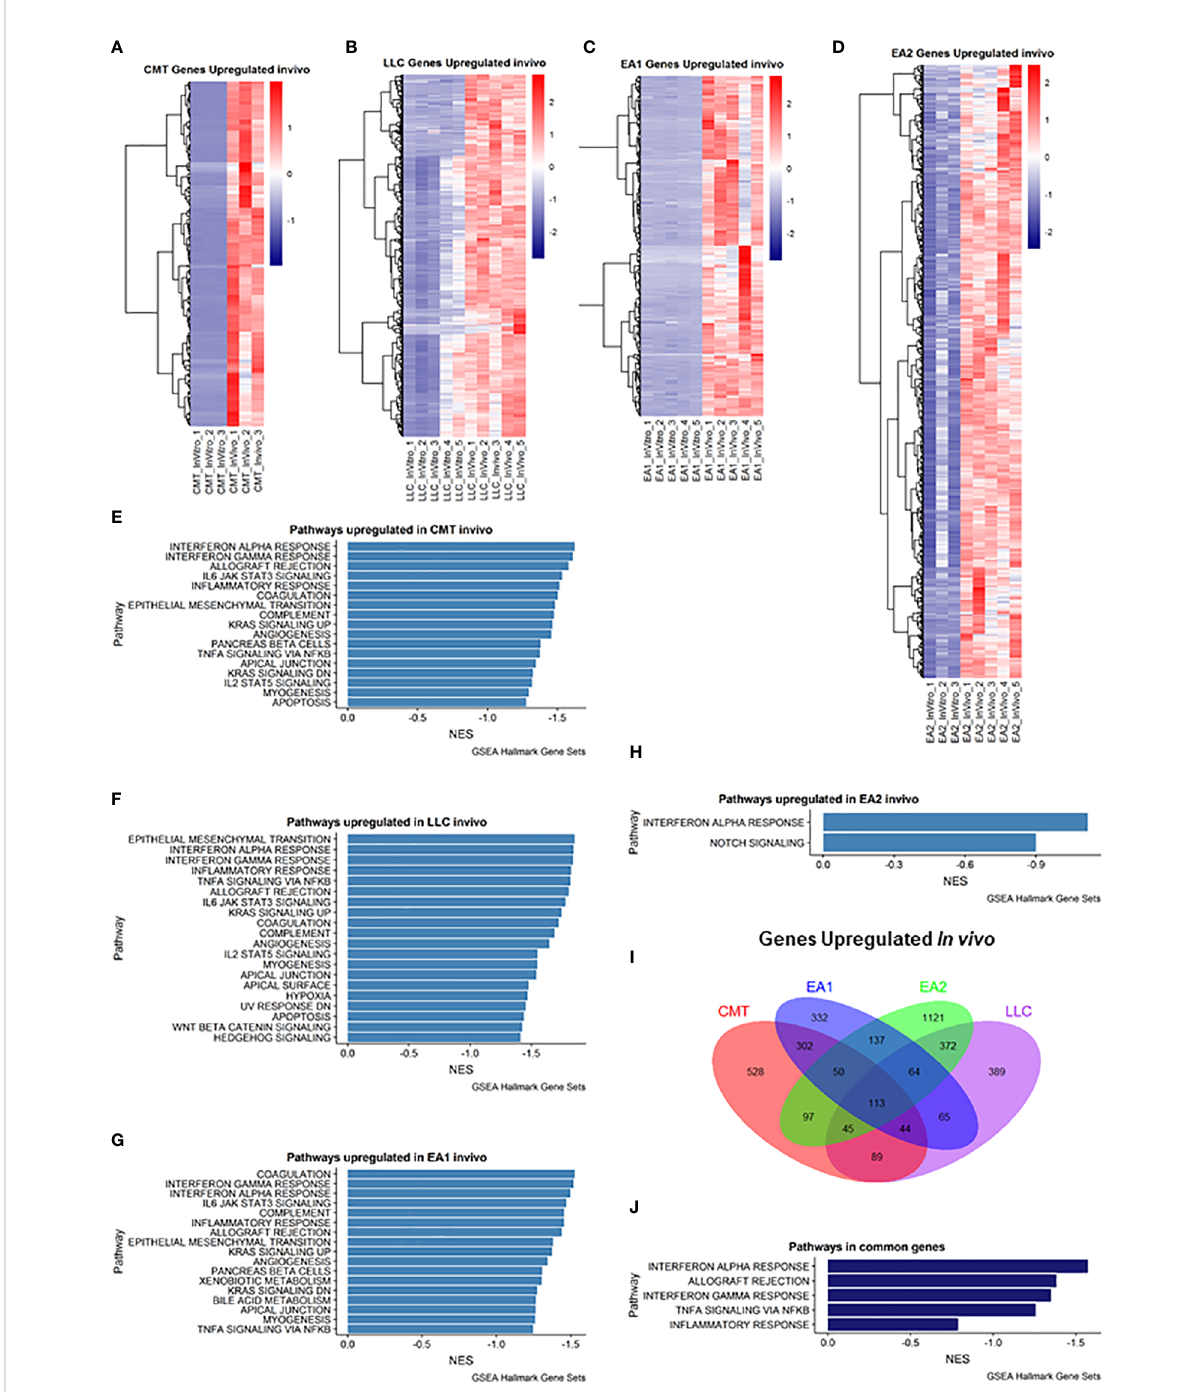
FIGURE 1 Analysis of genes upregulated in vivo compared to in vitro cells. (A – D) : Heat map of genes differentially upregulated in cells recovered from tumors ( in vivo ) compared to cells grown in culture ( in vitro ) for each of the cell lines: (A) CMT167, (B) LLC, (C) EA1, (D) EA2. Gene set enrichment analysis of Hallmark Gene Sets shows pathways upregulated in vivo compared to in vitro cells in CMT167 cells (E) , LLC cells (F) , EA1 cells (G) , and EA2 cells (H) . (I) Venn diagram shows genes commonly and/or differentially upregulated in all tumor types. (J) shows the common pathways upregulated in all 4 tumors. Differentially expressed genes were de fi ned as being in the leading edge of the GSEA and had a rank score of less than -1, and the FPKM value had to be greater than